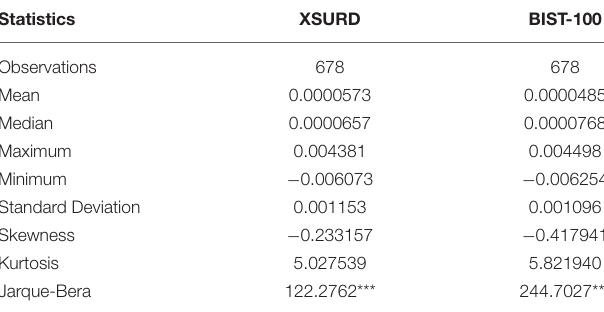
TABLE 2 | Unit root and diagnostic tests results. TABLE 3 | Mean and variance equation estimation of the bivariate VAR (1)-GARCH (1,1)-BEKK